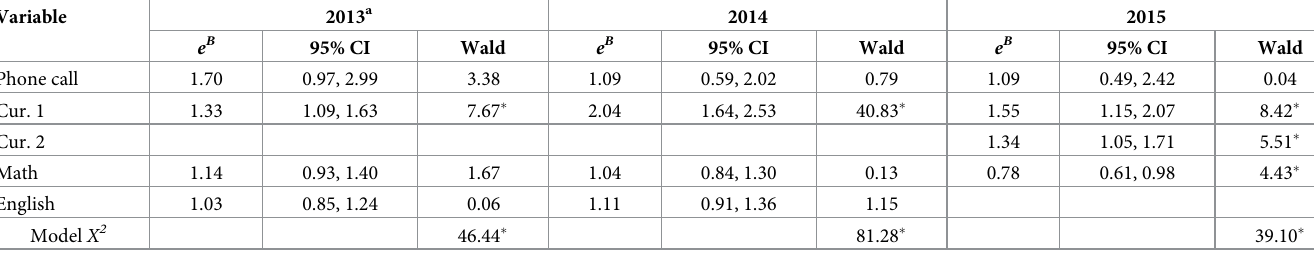
Table 5. Logistic regression results for predicting enrollment based on admission test